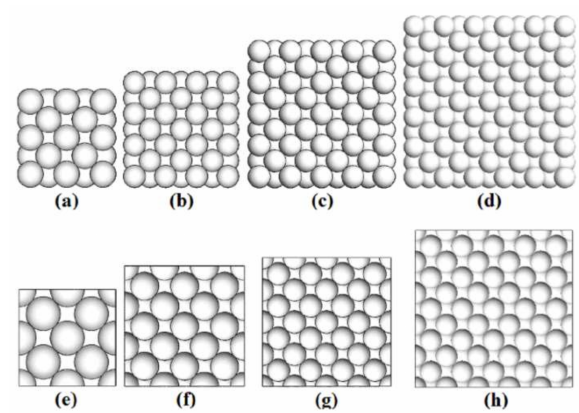
Figure 5. Faced-center cubic (FCC) samples; named as ( a ) 1; ( b ) 2; ( c ) 3; ( d ) 4; ( e ) 1cut; ( f ) 2cut; ( g ) 3cut; ( h )